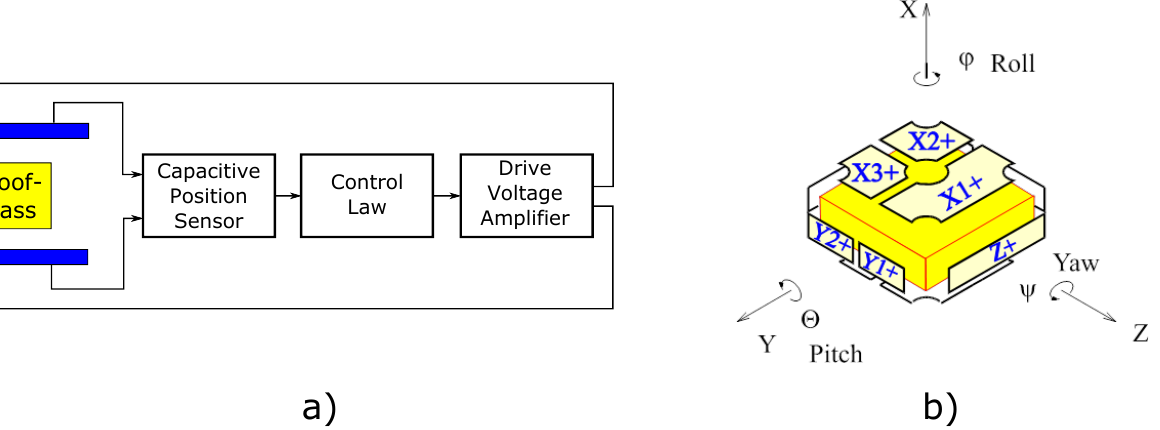
Figure 3. ( a ) Principle of the servo-control loop for one accelerometer’s axis. ( b ) Configuration of the electrodes around the proof-mass for the six-degree-of-freedom